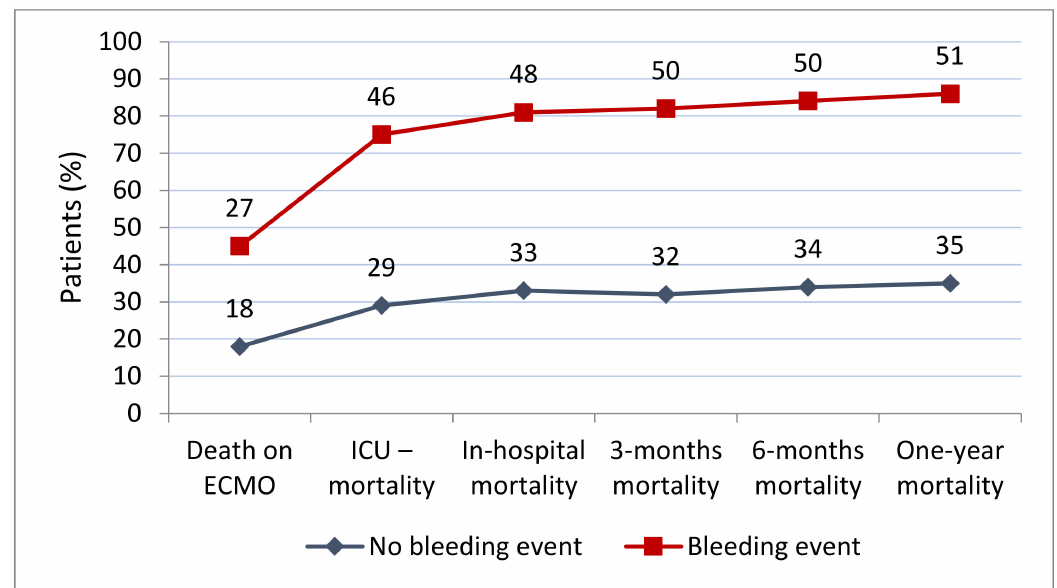
Figure 3. All-cause mortality in relation to time ( n = 132): patients with bleeding events (red) and patients without bleeding events (blue). ECMO: extracorporeal membrane oxygenation; ICU: intensive care unit.